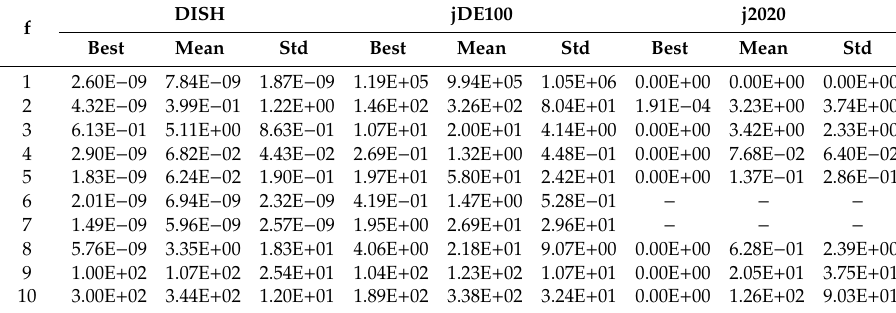
Table 19. DISH and jDE100 on CEC2020 in 5 D .